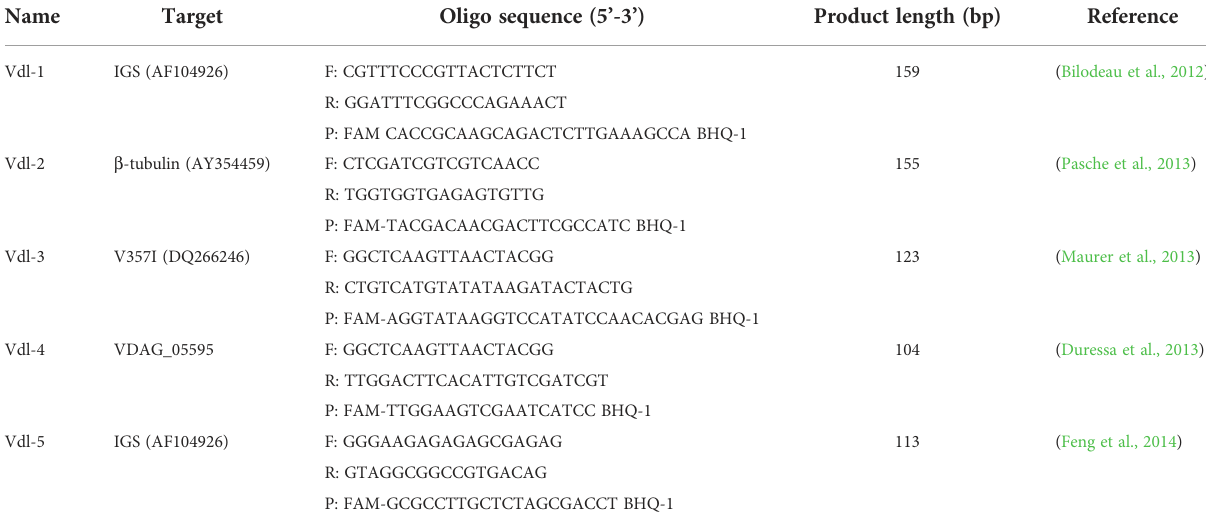
TABLE 1 Primers and probes used in this